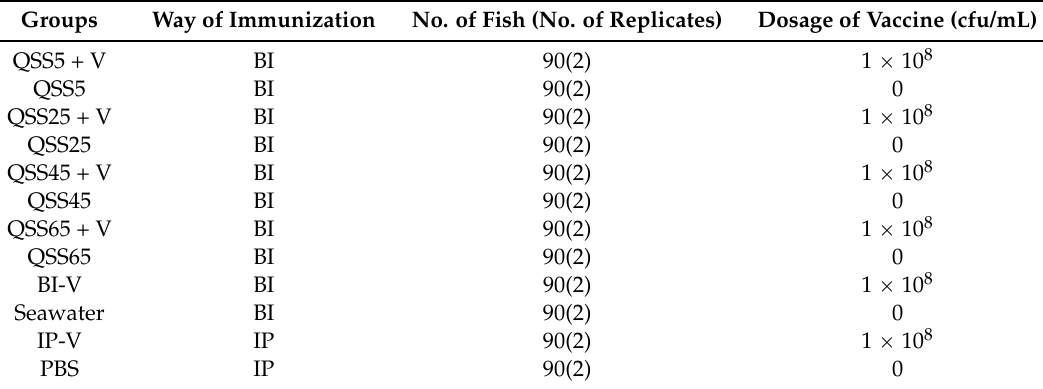
Table 2. Experimental design for